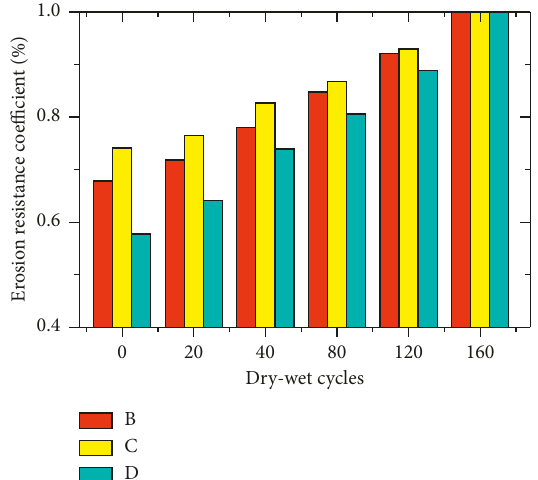
Figure 8: The relationship between erosion resistance coefficient and dry-wet cycles.